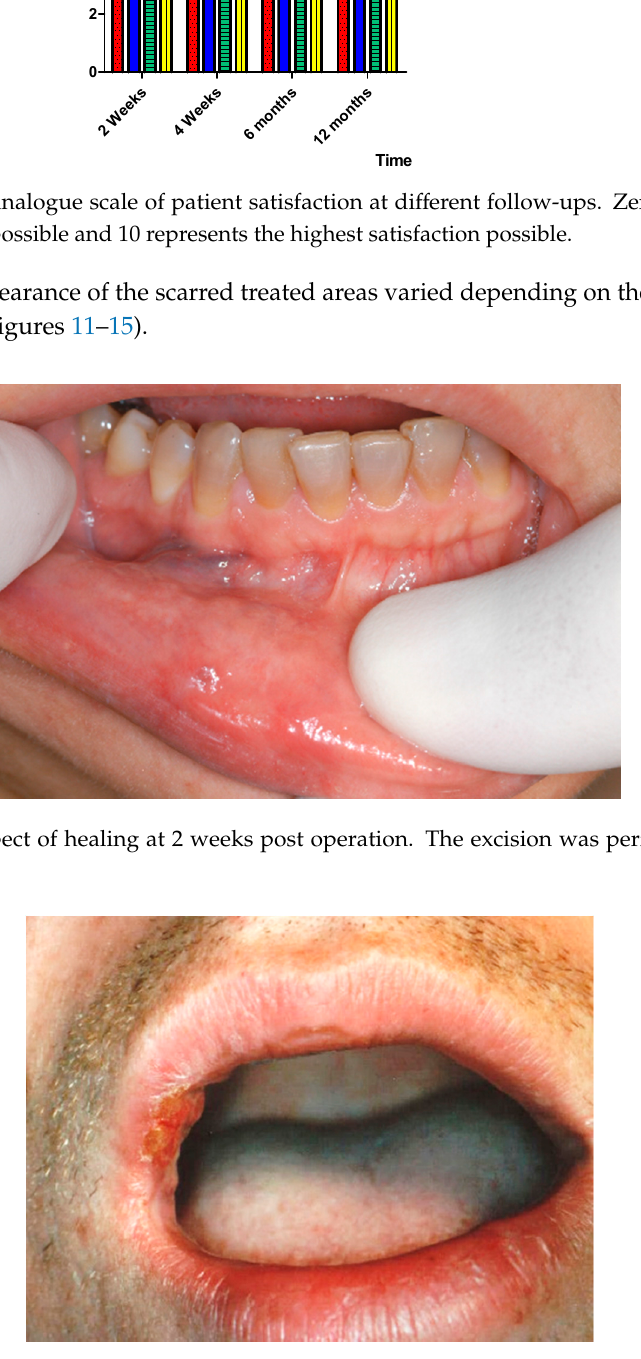
Figure 12. View of the healed area at 2 weeks post operation. The vaporization was performed using a CO 2